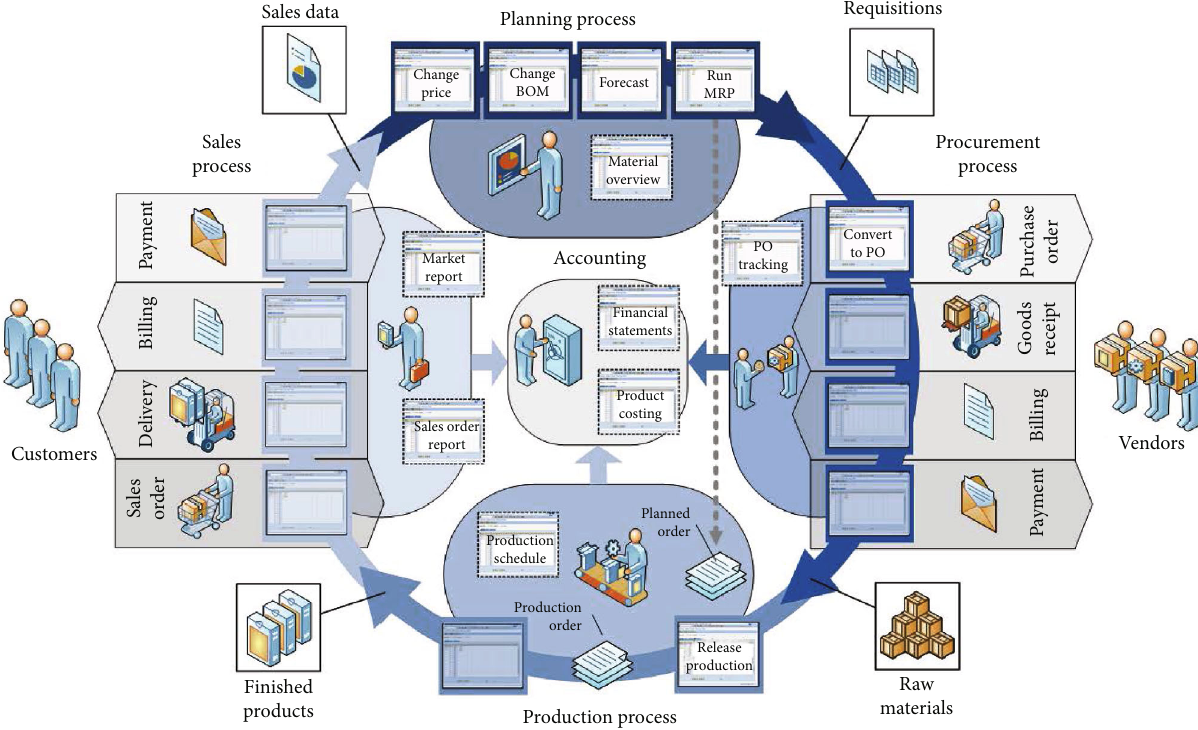
Figure 11: ERPsim manufacturing game.